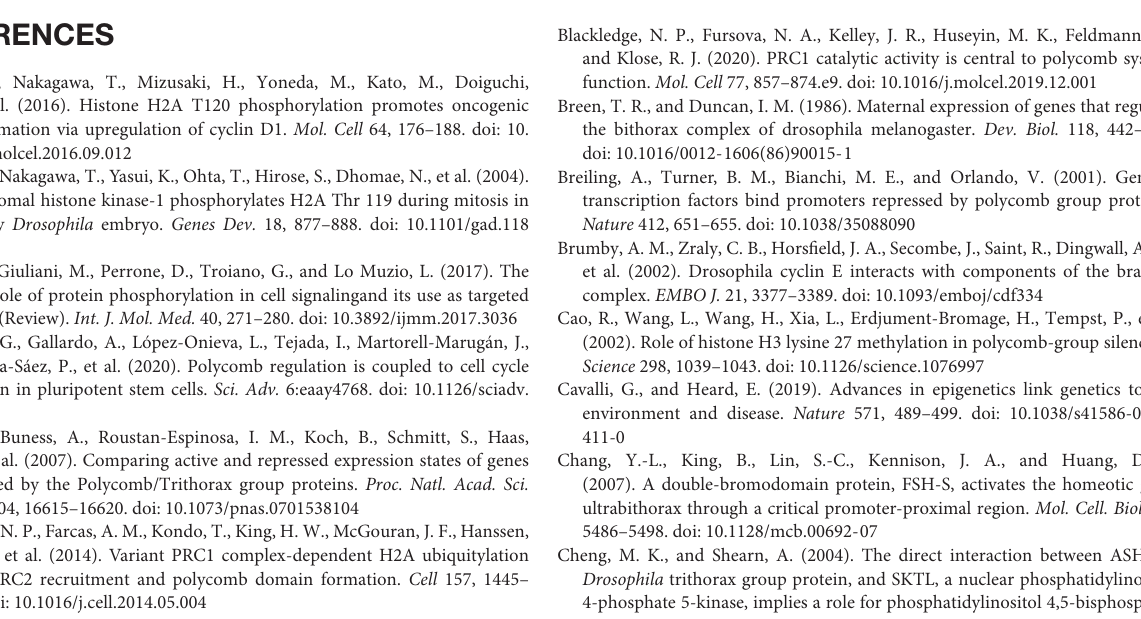
Supplementary Figure 1 | Schematic of ex vivo kinome-wide RNAi screen and data analysis. (A) 384-well plates containing dsRNAs against different genes were loaded with equal number of cells in each well. 24 h after seeding cells, PRE-F.Luc and Actin-R.Luc were co-transfected and luciferase values were determined 5 days later. (B) Box plots representing plate median normalized data for kinome-wide RNAi screen, replicate 1 (left) and replicate 2 (right). Supplementary Figure 2 | Confirmation of ball knockdown. Protein lysates were prepared from cells treated with dsRNA against ball for 4 days and were analyzed by Western blotting. A drastic decrease in the amount of BALL protein was observed as compared to cells treated with LacZ dsRNA. Supplementary Table 1 | Cell cycle specific gene ontology classes are enriched in the list of candidate genes. Analysis was performed using PANTHER classification system with the HD2 kinome subset as reference. Fourth column contains the number of genes expected in the candidate gene list for each GO term based on the reference list. Enrichment of GO terms was calculated by dividing the number of genes in the candidate list belonging to each GO term by its expected number. A p -value of 0.05 was used as cut-off to shortlist the GO terms. Supplementary Table 2 | List of peaks generated using ChIPseeker and presented along with their